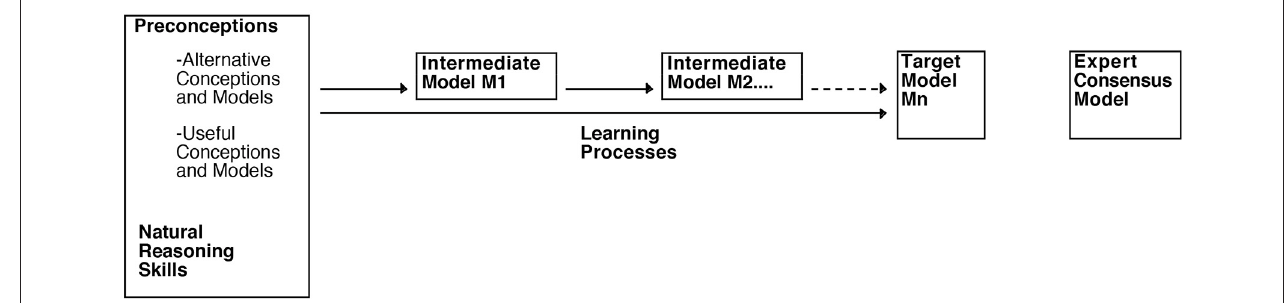
FIGURE 3 | Model evolution sequence with intermediate models (reprinted with permission from Clement, 2000, p.